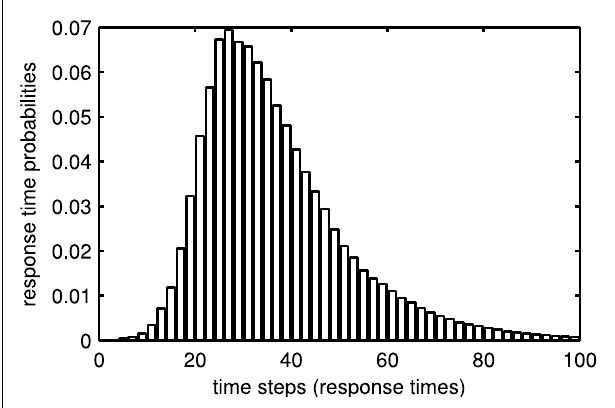
FIGURE 7 | Response time distribution for alternative A = (9, 1) in the compromise setup with θ = 5, ξ = 0.01, λ = 0.05, and µ = 0. The expected response time, i.e., the mean of the distribution is